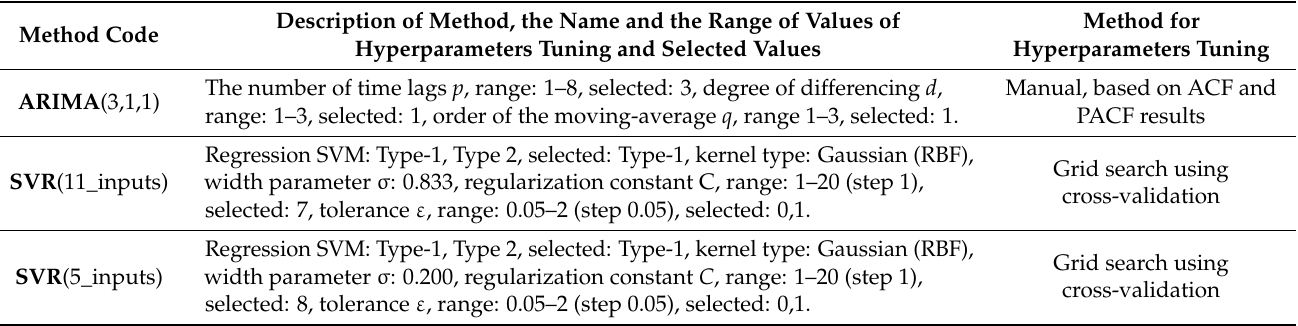
Table A3. Results of hyperparameters tuning for proposed single methods for time series No. 2. Description of Method, the Name and the Range of Values of Method Code Hyperparameters Tuning and Selected